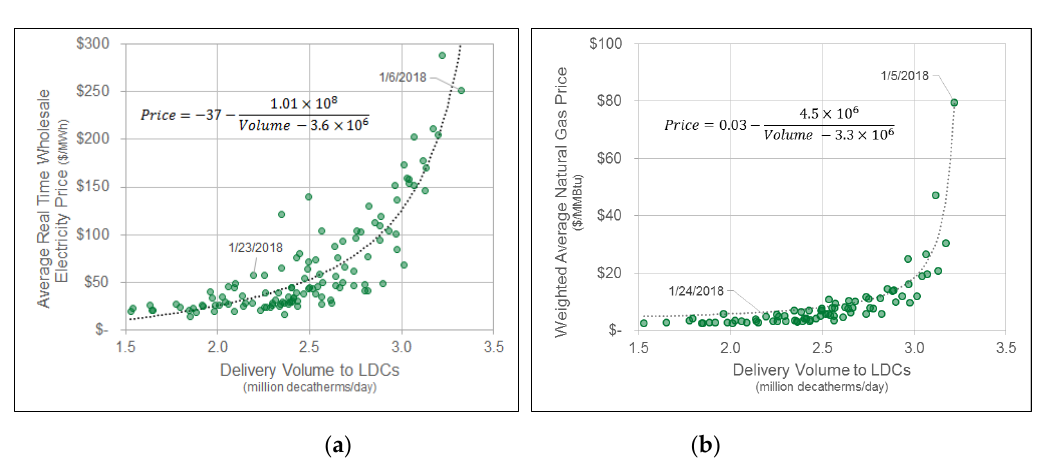
Figure 5. Average daily prices for electricity and natural gas during the winter of 2017–2018 fit with inverse functionals shown as dotted lines. ( a ) Natural gas prices for Algonquin Citygate and Tennessee zone 6 versus total daily delivery volumes to LDCs on both pipelines, R 2 = 0.889. ( b ) Electricity prices for the ISO-NE trading hub versus total daily delivery volumes to the LDCs, R 2 = 0.793. Data Sources: S&P Global Market Intelligence for NG volume and price data [44,45]; ISO-NE Pricing Reports, Zonal Information for electricity prices [46].